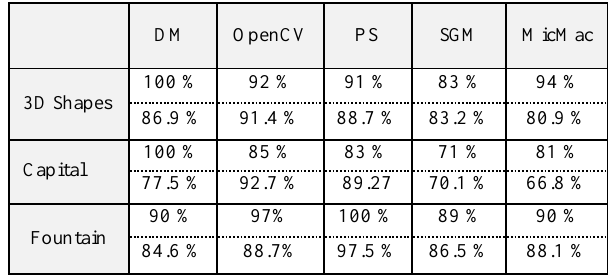
Table 2: Relative accuracy of the reconstructed DSM.